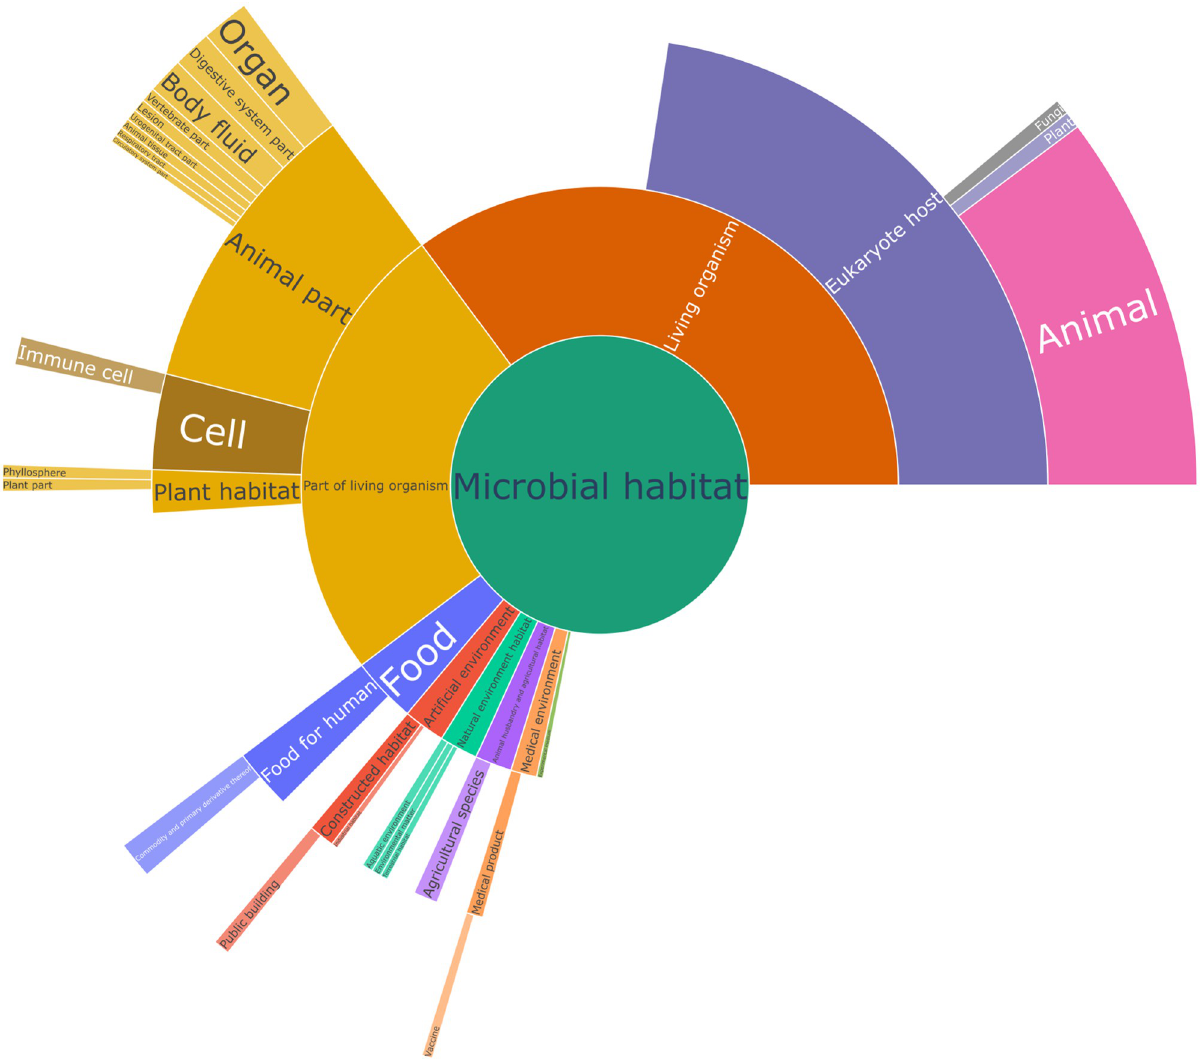
Fig 6. Distribution of habitats in Lives_In relations extracted from PubMed. This chart represents the habitats at the four highest levels in the OntoBiotope ontology. The arc is proportional to the number of Lives_In relations extracted from PubMed that involve the habitat or any descendant in OntoBiotope. Only habitats with more than 20,000 occurrences are shown for